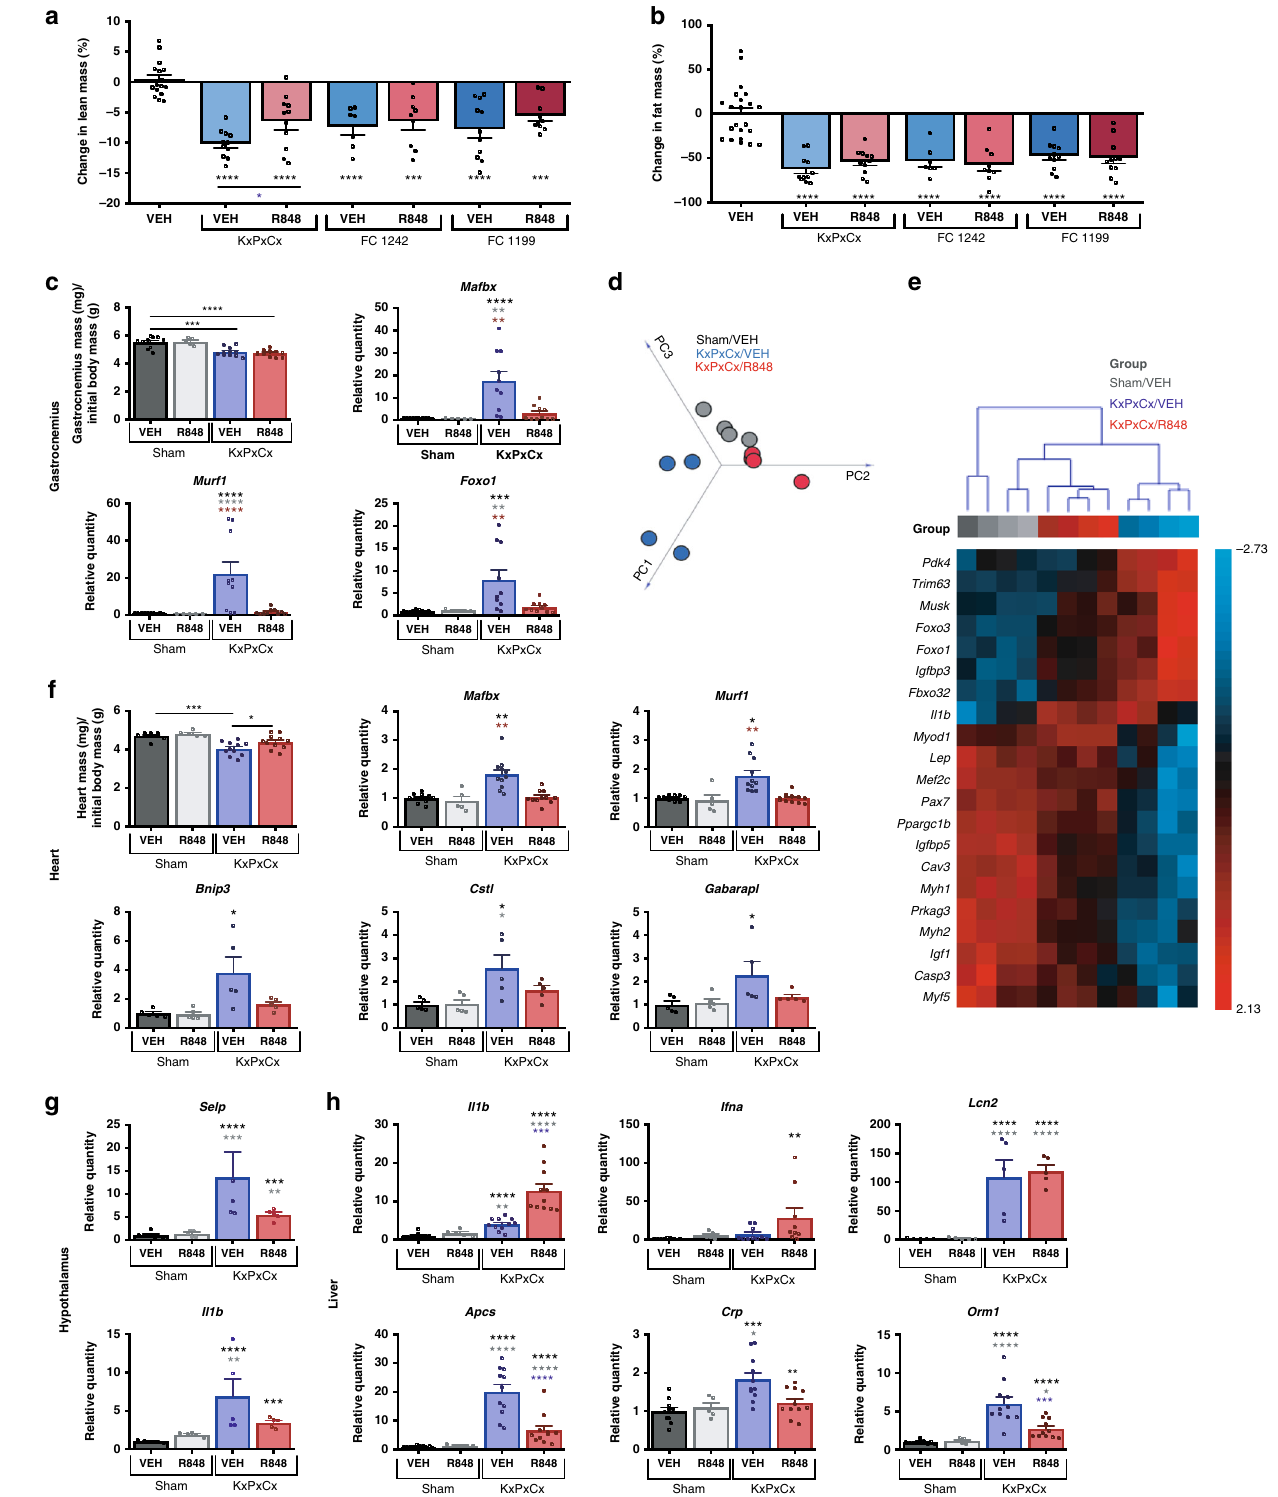
(Fig. 6a). Contrary to the results in TLR7-suf fi cient mice, KxPxCx-engrafted TLR7KO mice treated with R848 experi- enced increased tumor growth relative to vehicle-treated mice (Fig. 6b,